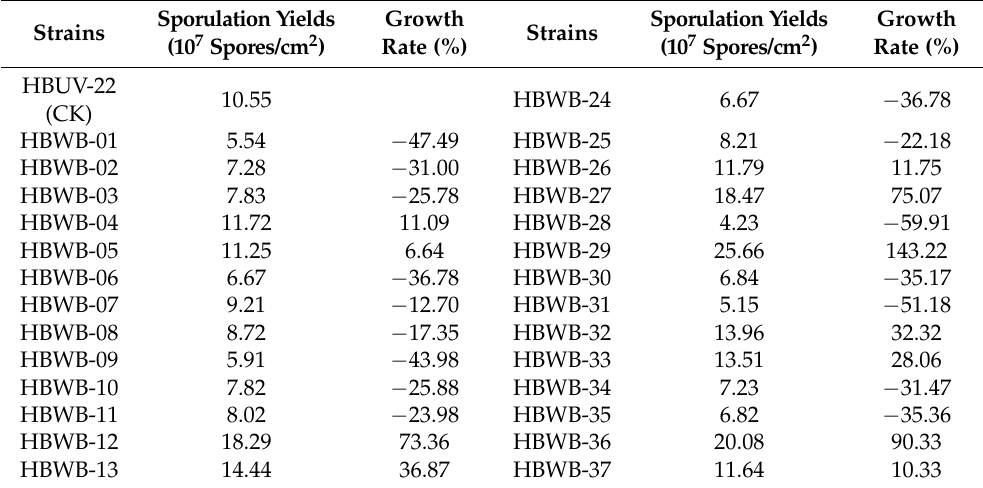
Table 3. Sporulation yields of 47 B. bassiana strains by microwave mutagenesis.